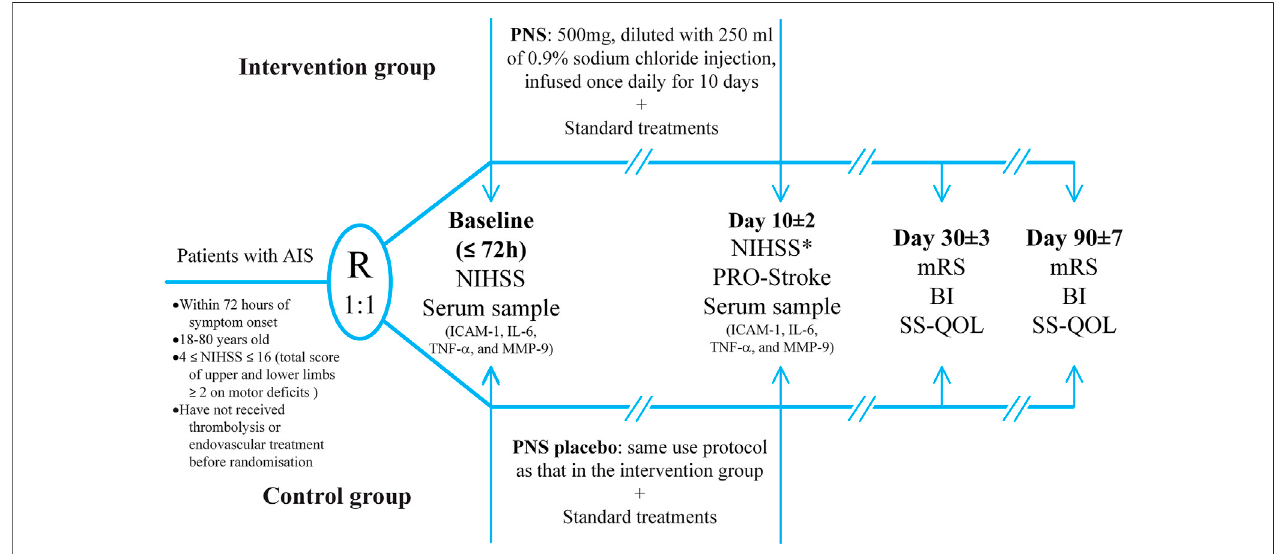
FIGURE 1 | The fl owchart of the EXPECT trial.